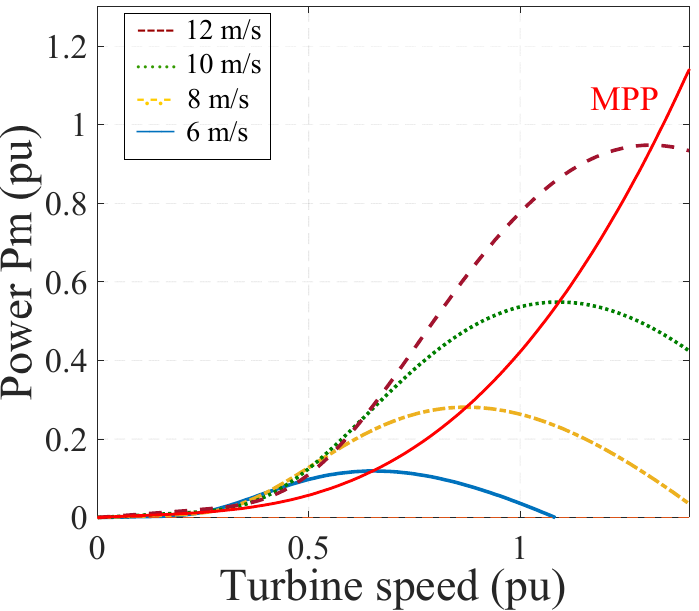
Figure 4. 𝑃 (cid:3040) − 𝜔 curves at different wind speeds. Figure 4. P m − ω curves at different wind